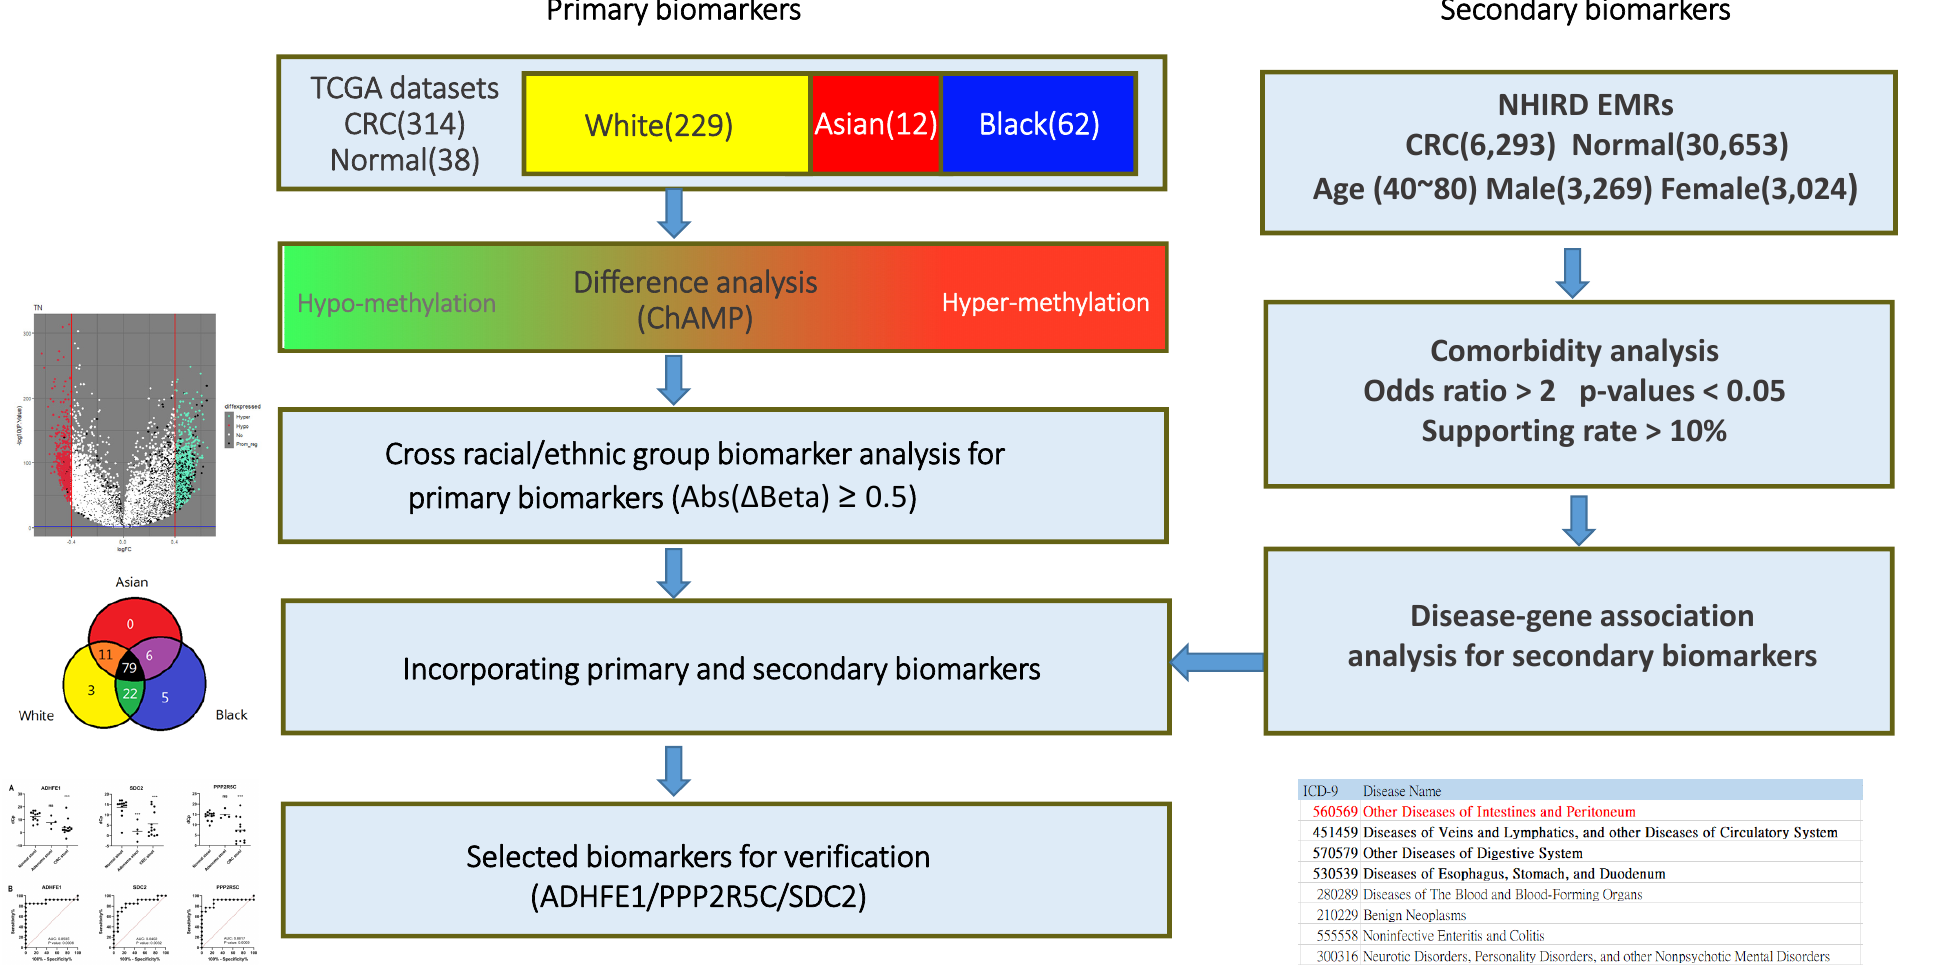
Figure 1. Flow chart showing the pipeline for identification of primary biomarkers from DNA methylation analysis using TCGA and secondary biomarkers from the Taiwan’s